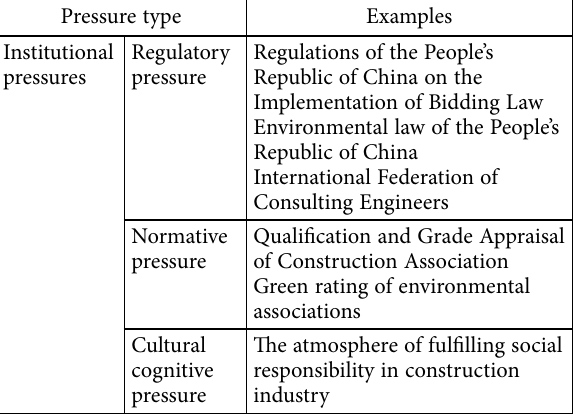
Table 1. Examples of the institutional